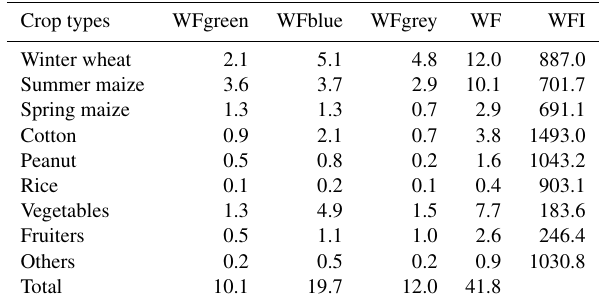
Table 4. WF (km 3 ) and the WFI (m 3 t − 1 ) of each